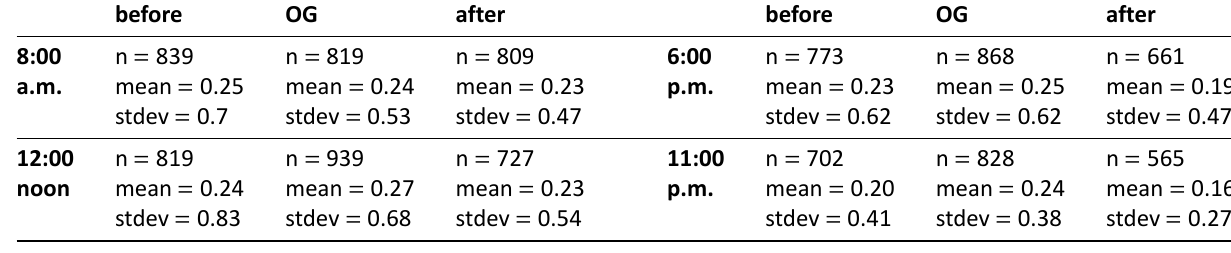
Table 3. Values for the hot spot analysis using KDE for residents’ positive tweets for specific hours.